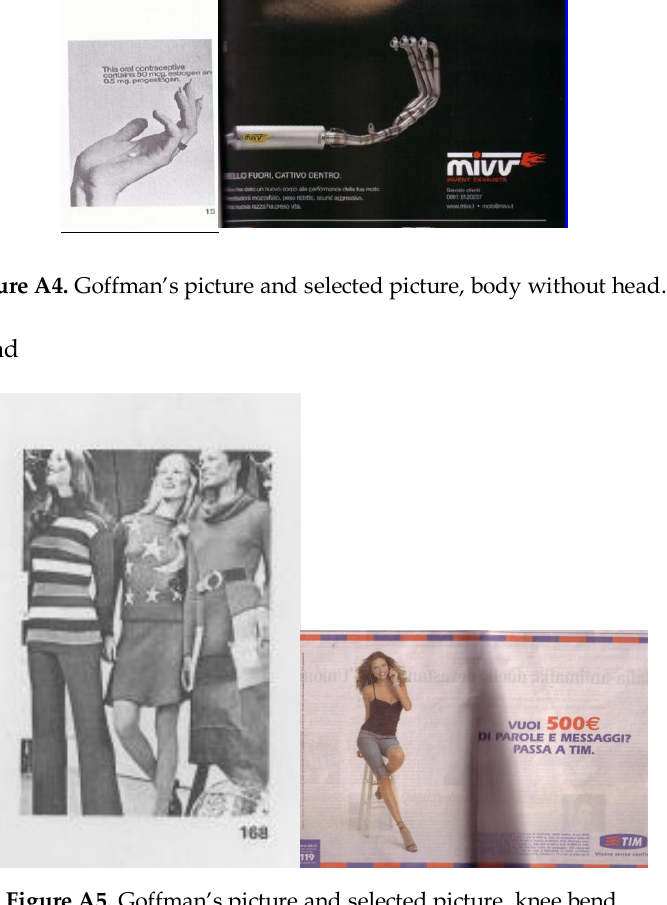
Figure A5. Goffman’s picture and selected picture, knee